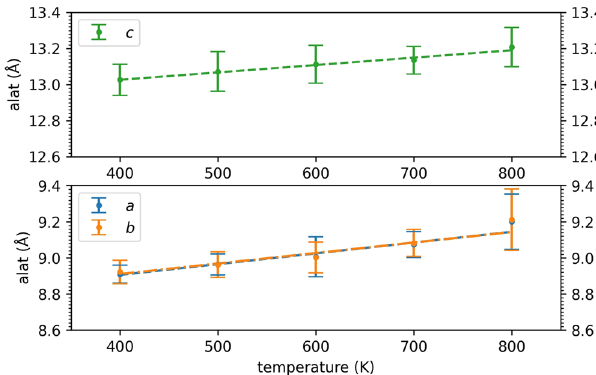
Fig. 5 Temperature dependence of the t-LGPS lattice parameters (for o-LGPO see Supplementary Figure 11). The error bars are the standard deviations over the blocks, from a block analysis performed for each lattice parameter, as shown in Fig. 3 for the elastic moduli.